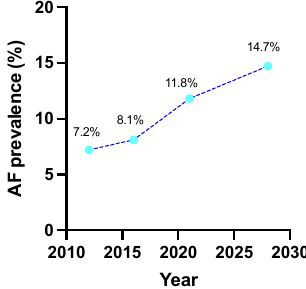
Figure 3. Exponential smoothing analysis by additive damped trend method for forecasted prevalence of AF in hypertensive Romanian adults. AF = atrial fibrillation.